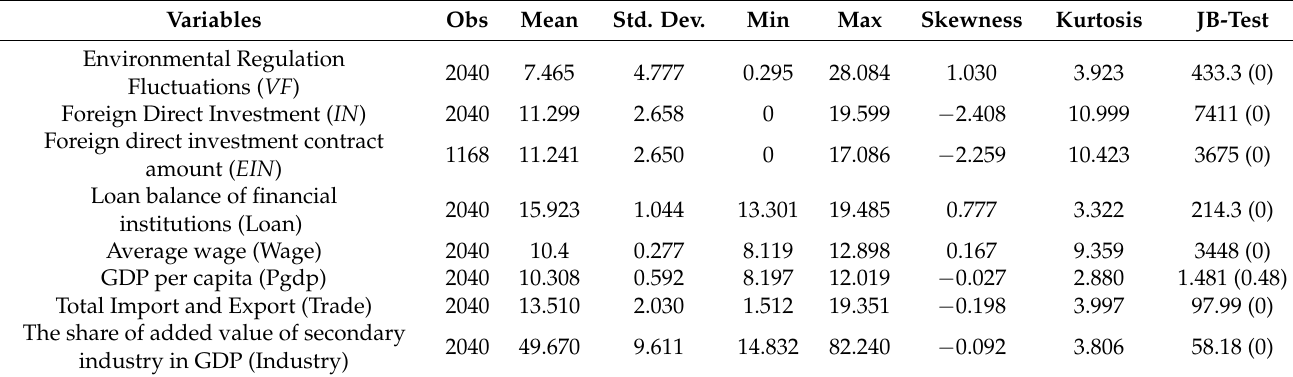
Table 1. Descriptive statistics of variables.